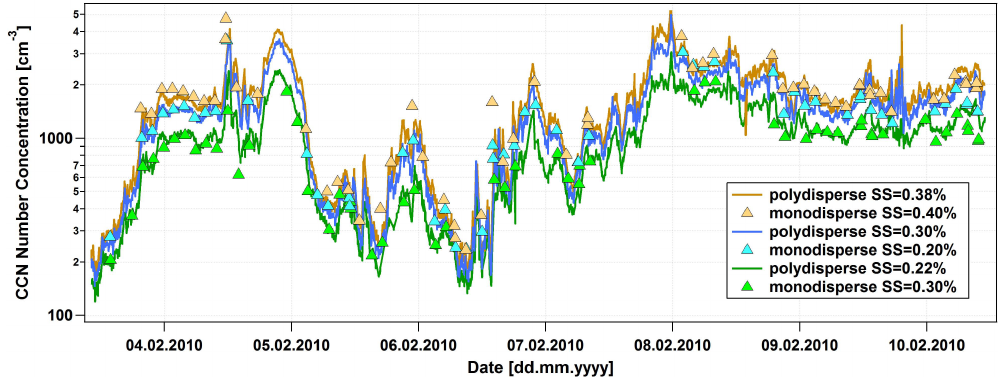
Fig. 4. SS dependent CCN number concentration from the direct polydisperse measurement (lines) and from the integrated CCN number size distribution measurements (triangles).